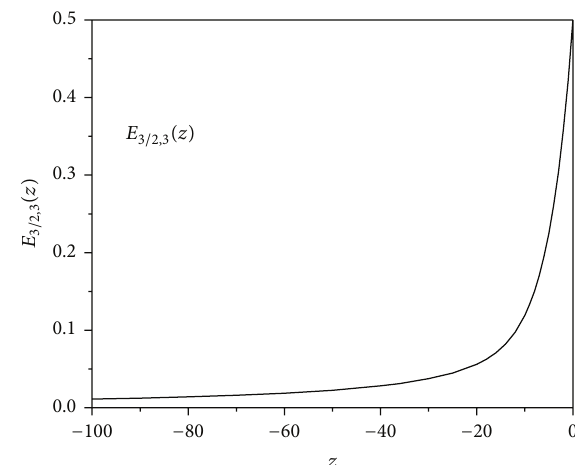
Figure 2: Typical Mittag-Leffler function in [ 1/∞ ].